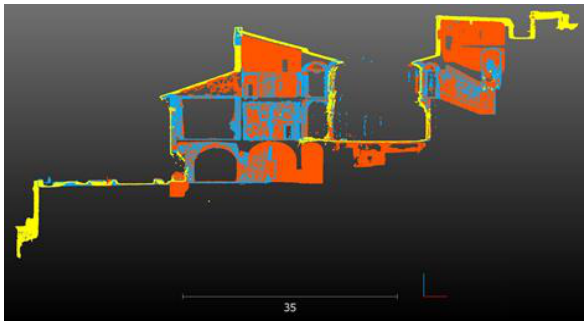
Figure 2. Primary data acquisition: photogrammetric images (yellow), TLS point clouds (red), and SLAM point clouds